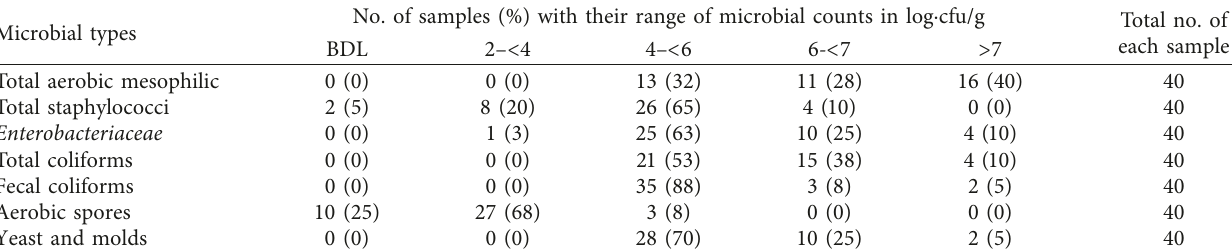
Table 4: Microbial load in log · cfu/g of the total samples with their range of microbial counts. No. of samples (%) with their range of microbial counts in log · cfu/g Total no. Microbial types